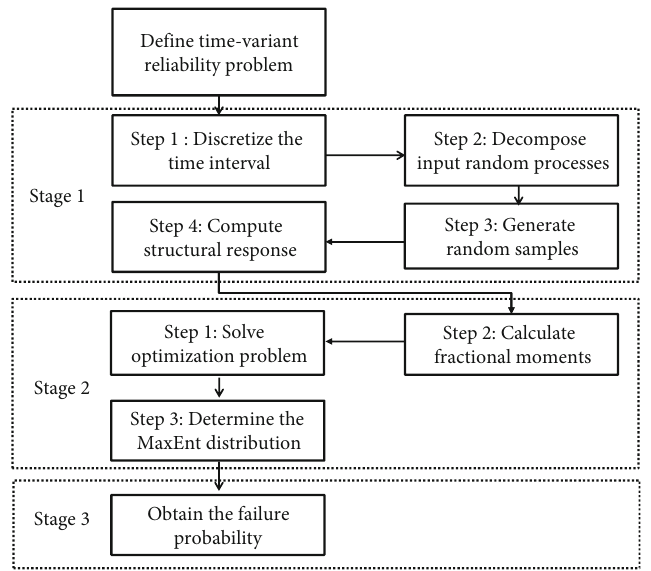
Figure 1: Procedure of the proposed method.